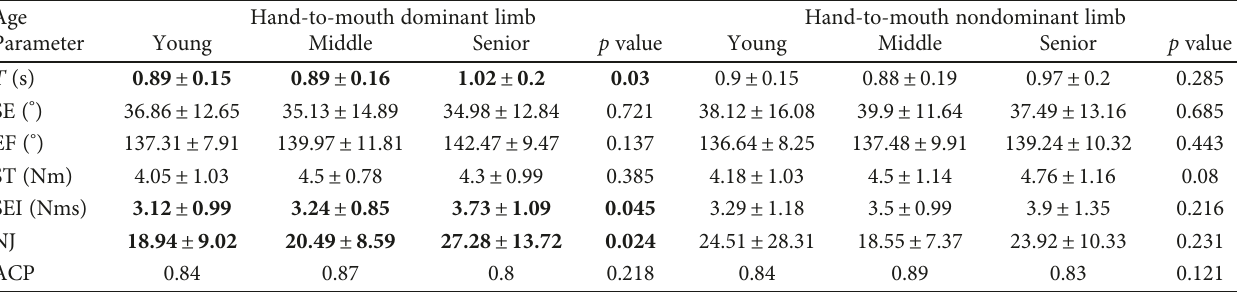
Table 6: Age subset: hand-to-mouth.